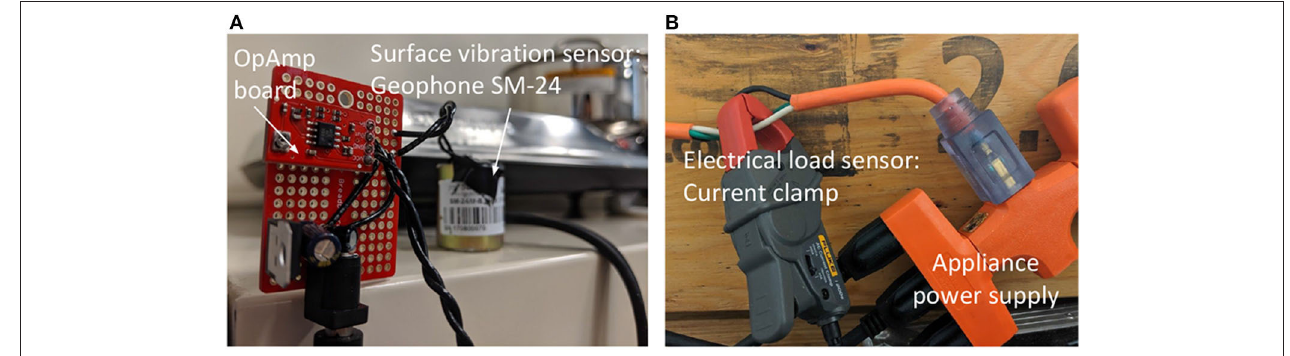
FIGURE 2 | Structural vibration sensor and electrical load sensor used in this work. (A) Structural vibration sensor. (B) Electrical load sensing.